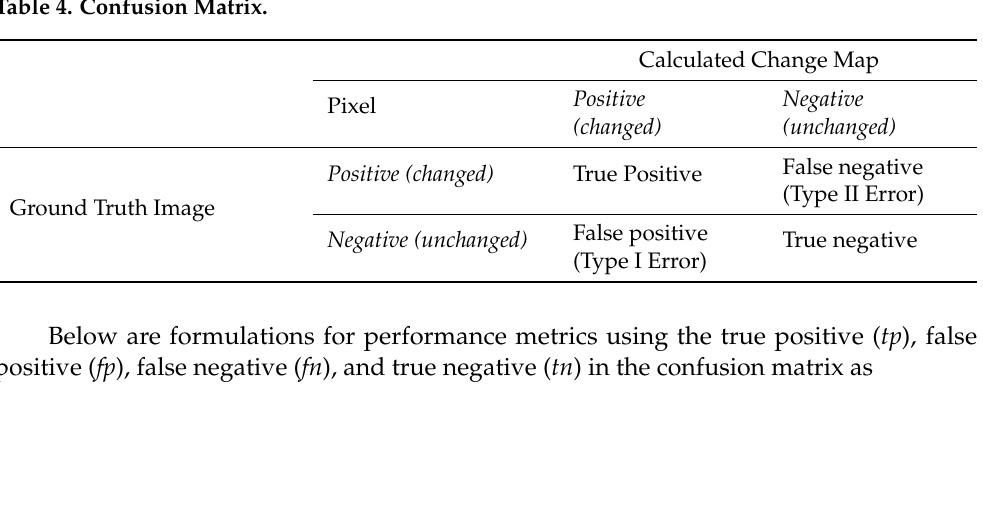
Table 4. Confusion